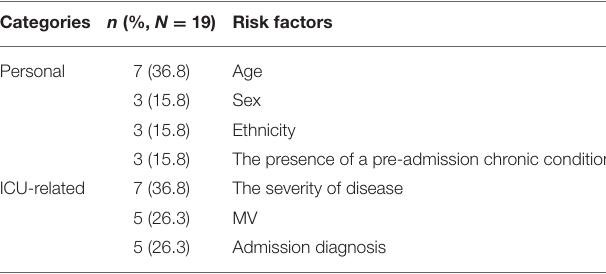
TABLE 3 | The most common risk factors reported in over 3 studies for physical